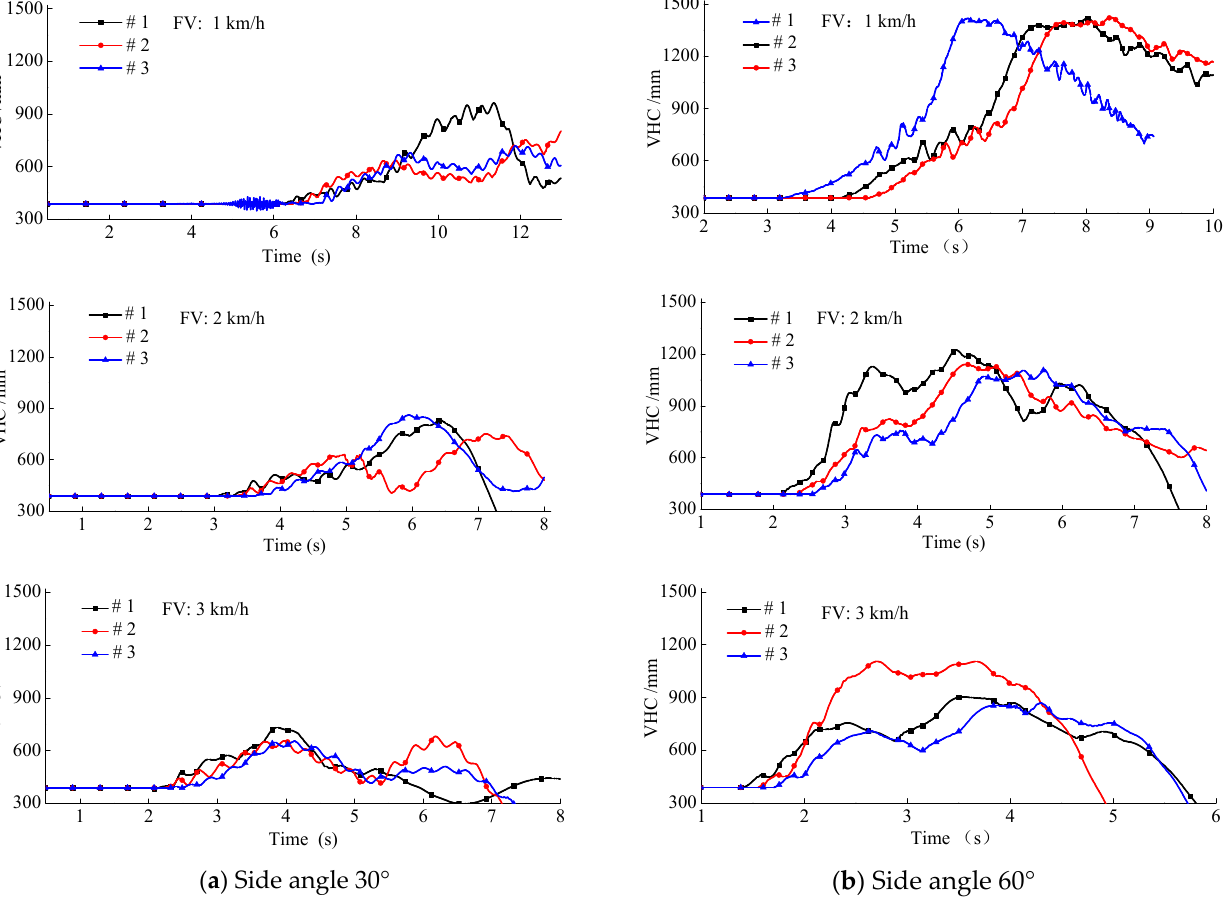
Figure 9. Change of VHC in side and forward LS.